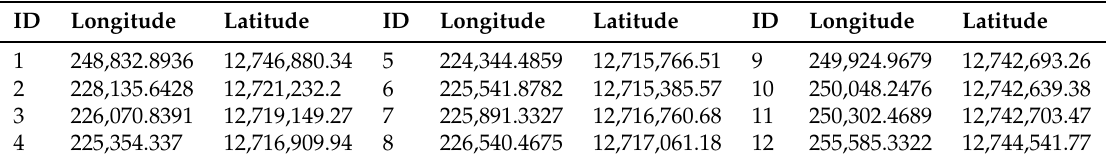
Figure 8. New proposal of the Culiacan River Watershed with some verification field points. Table 1. Location of the verification sites to identify possible modifications in the watershed divide proposal.